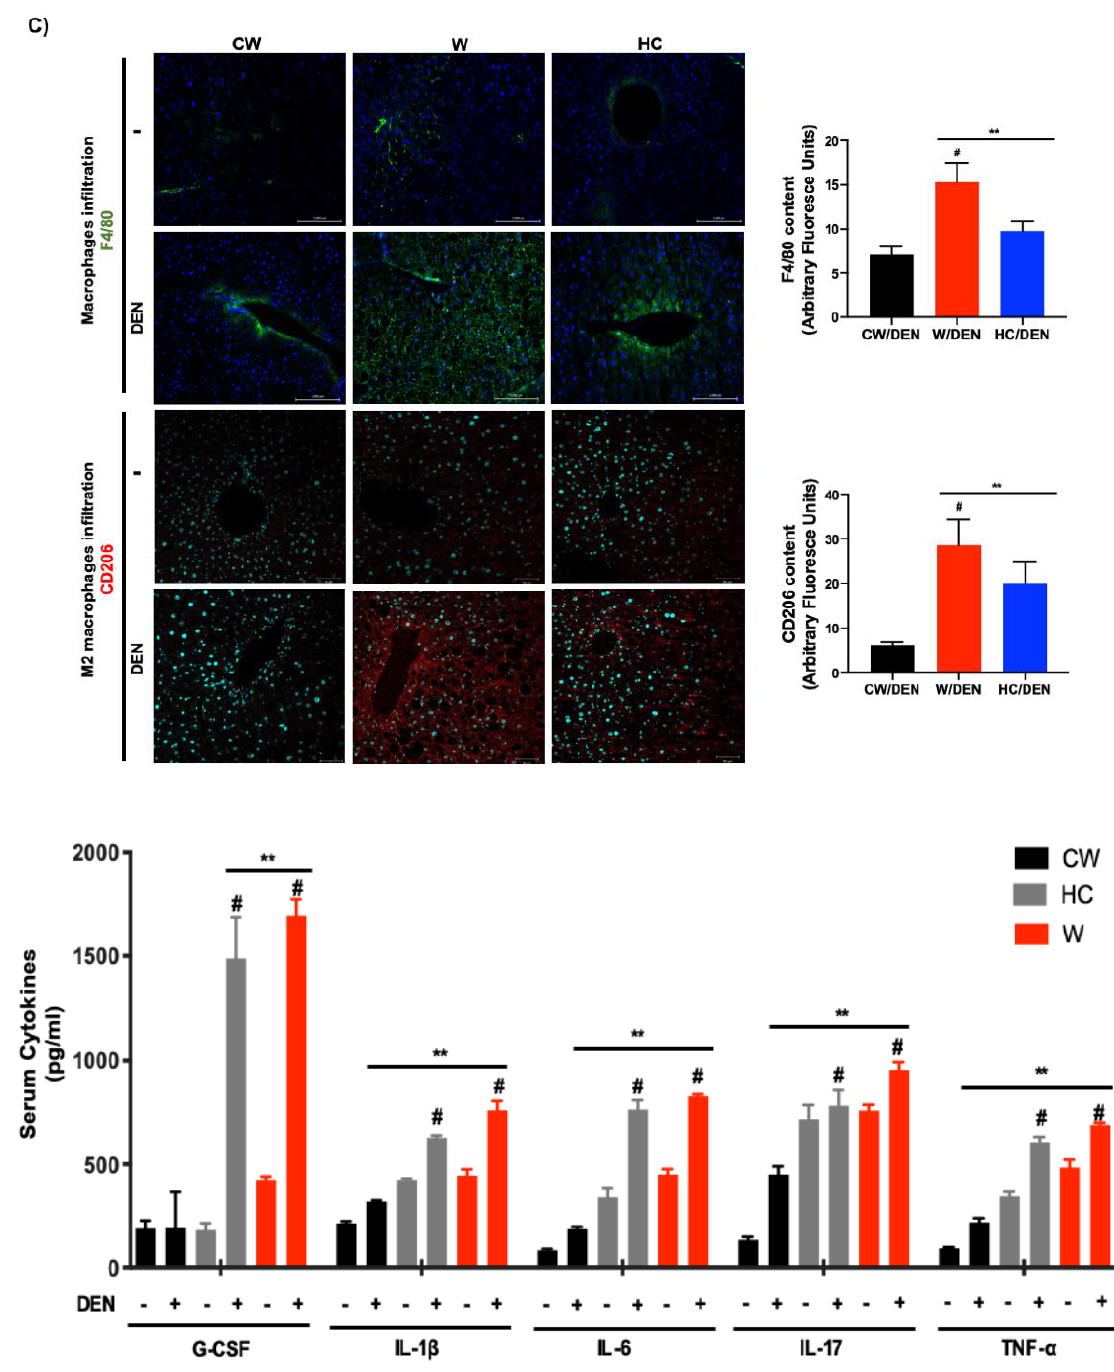
Figure 4. Inflammation is a distinctive feature in liver tumors associated with lipid-enriched and cholesterol diet consump- tion. ( A ) Gene set enrichment analysis (GSEA) of hallmark IL6-Jak-STAT3 signaling, data set comparing W/DEN and HC/DEN to CW/DEN ( n = 4). ( B ) Process networks analysis related to inflammation in tumors from CW/DEN (black), W/DEN (red) and HC/DEN (blue) ( n = 4). The top rank-ordered processes and networks are based on statistical significance ( p < 0.01). ( C ) Macrophages infiltration by immunofluorescence of F4/80 (green fluorescence) and CD206 (M2 phenotype, red fluorescence), representative images of four animals per group, original magnification, 100X. Quantification of F4/80 and CD206 fluorescence. ( D ) Proinflammatory cytokines serum concentration of all mice groups. Proteins were determined by based multiplex immunoassay ( n = 4). Each bar represents the average ± SEM ** p < 0.01 vs. CW group; # p < 0.05 vs. W diet alone group.